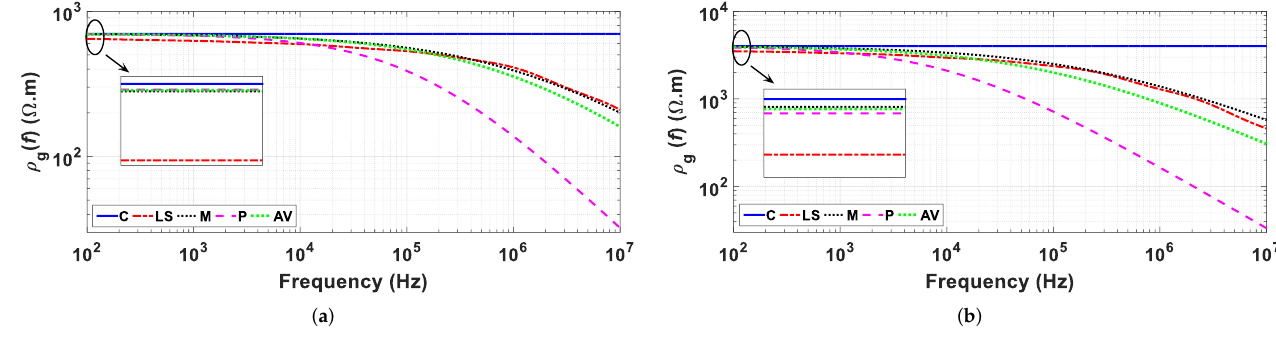
Figure 2. Soil resistivity as a function of frequency with ρ 0 of: ( a ) 700 Ω · m and ( b ) 4000 Ω · m.